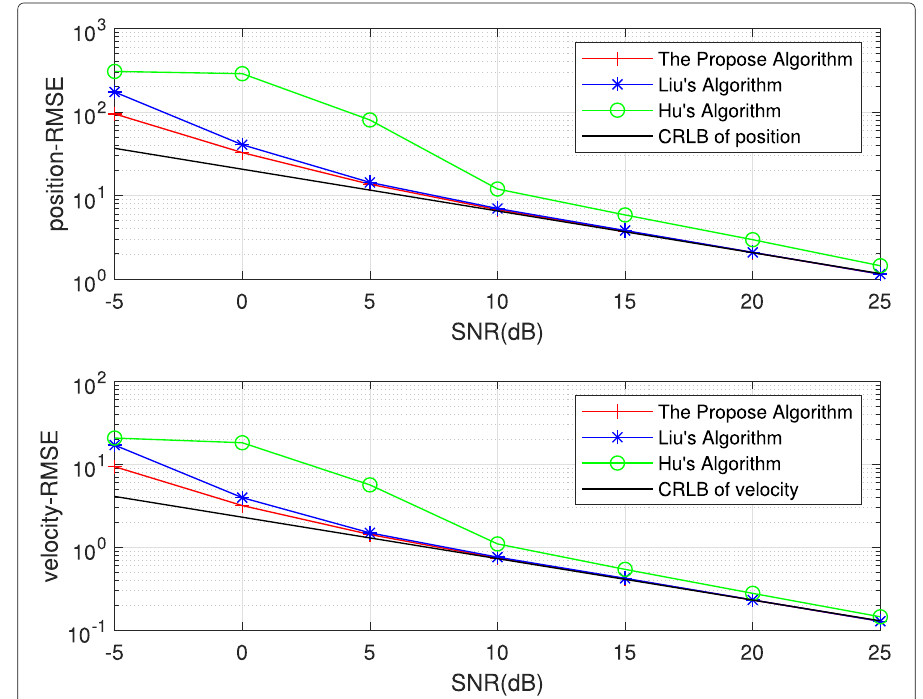
Fig. 1 RMSE comparison of three algorithms for the near field source